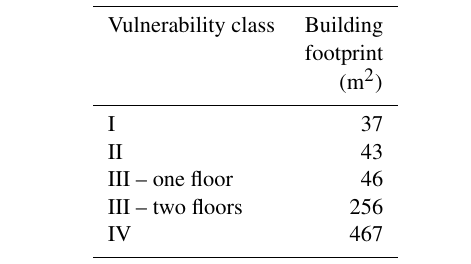
Table 3. Building footprints derived for Ethiopia from the ImageCat data.